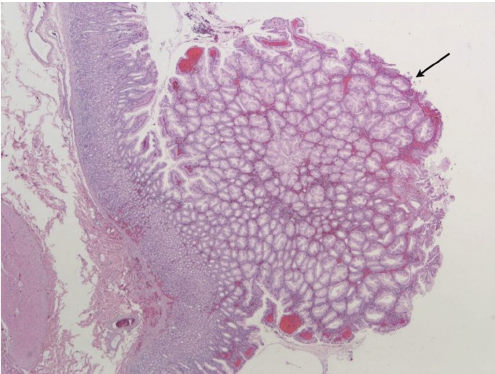
F 1: Microscopic image of surgical specimen showing hyper- plastic gastric polyp.